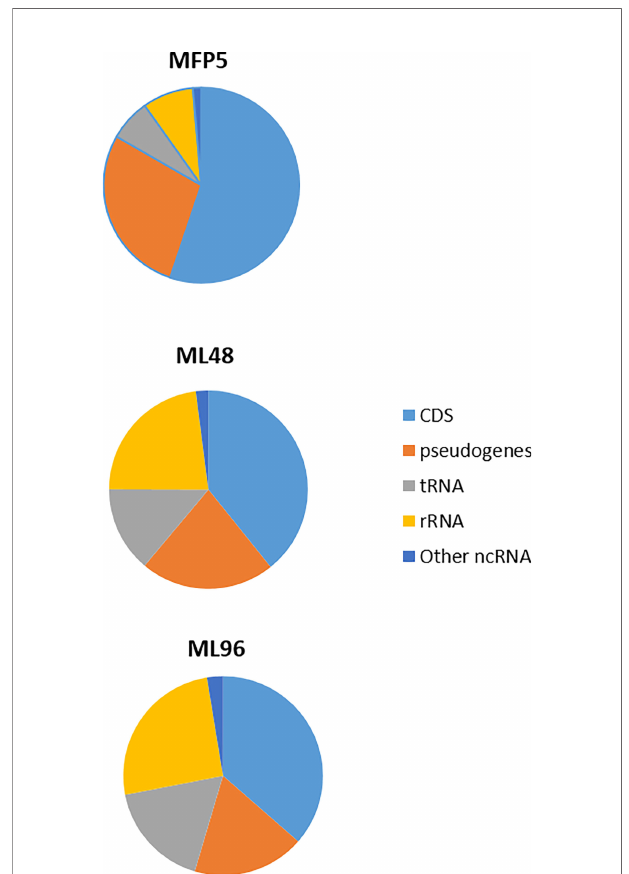
FIGURE 2 | Percentage of transcripts, from MFP5, ML48 and ML96, aligning to coding DNA sequences (CDS), pseudogenes, transfer-RNA